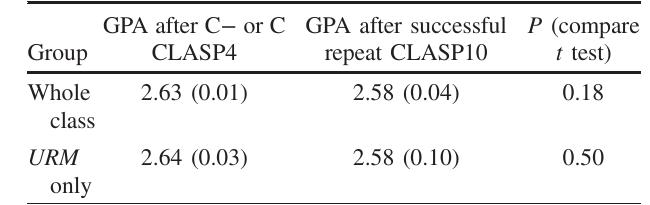
TABLE XII. GPAs of student work after they have completed the CLASP physics series. We compare students from percent scale graded classes who repeated the course and received higher grades with students from 4-point scale classes who received grades C − or C and so could not repeat the course. Standard errors are shown in